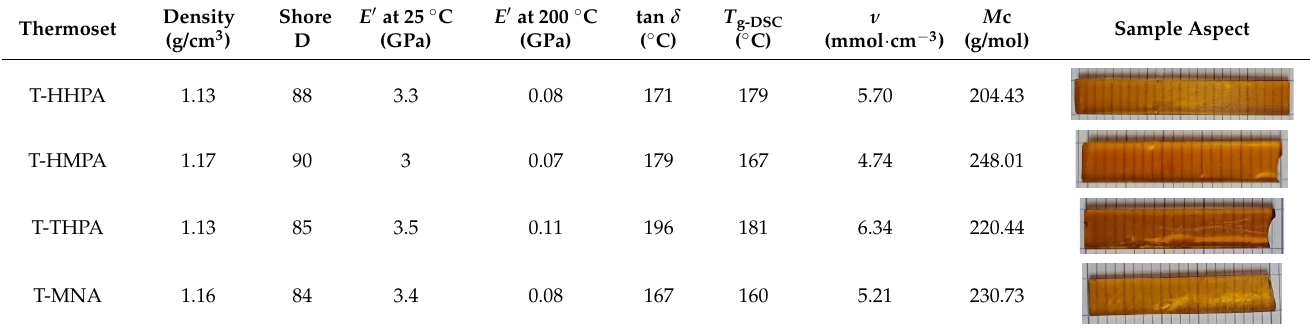
Table 3. Thermo-mechanical and network properties of the designed thermosets.